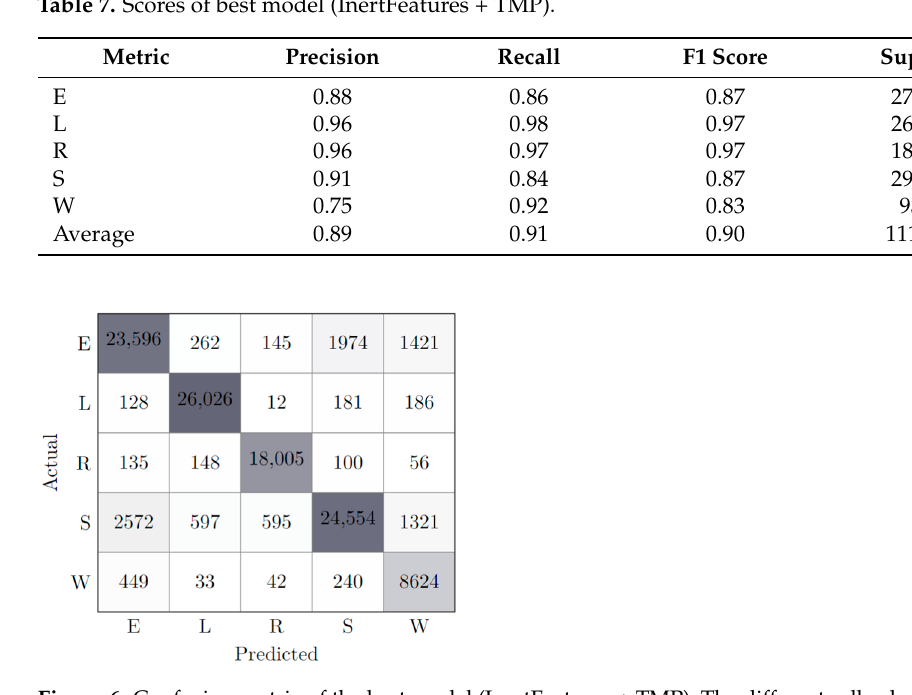
Figure 6. Confusion matrix of the best model (InertFeatures + TMP). The different cell colors represent the classification accuracy; the more accurate the classification of a state, the darker the cell is represented.